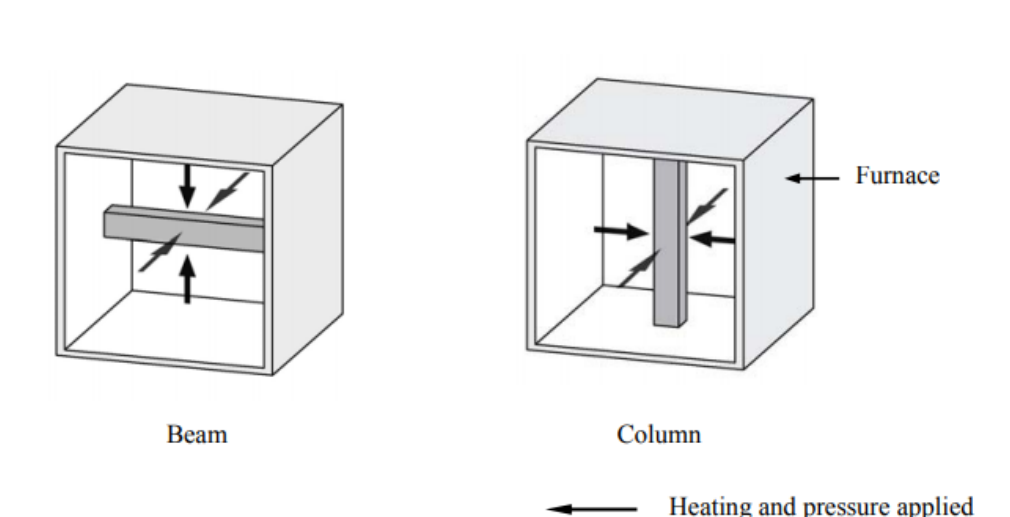
Figure 3. Pressure and heating applied on a test sample according to BS 476.